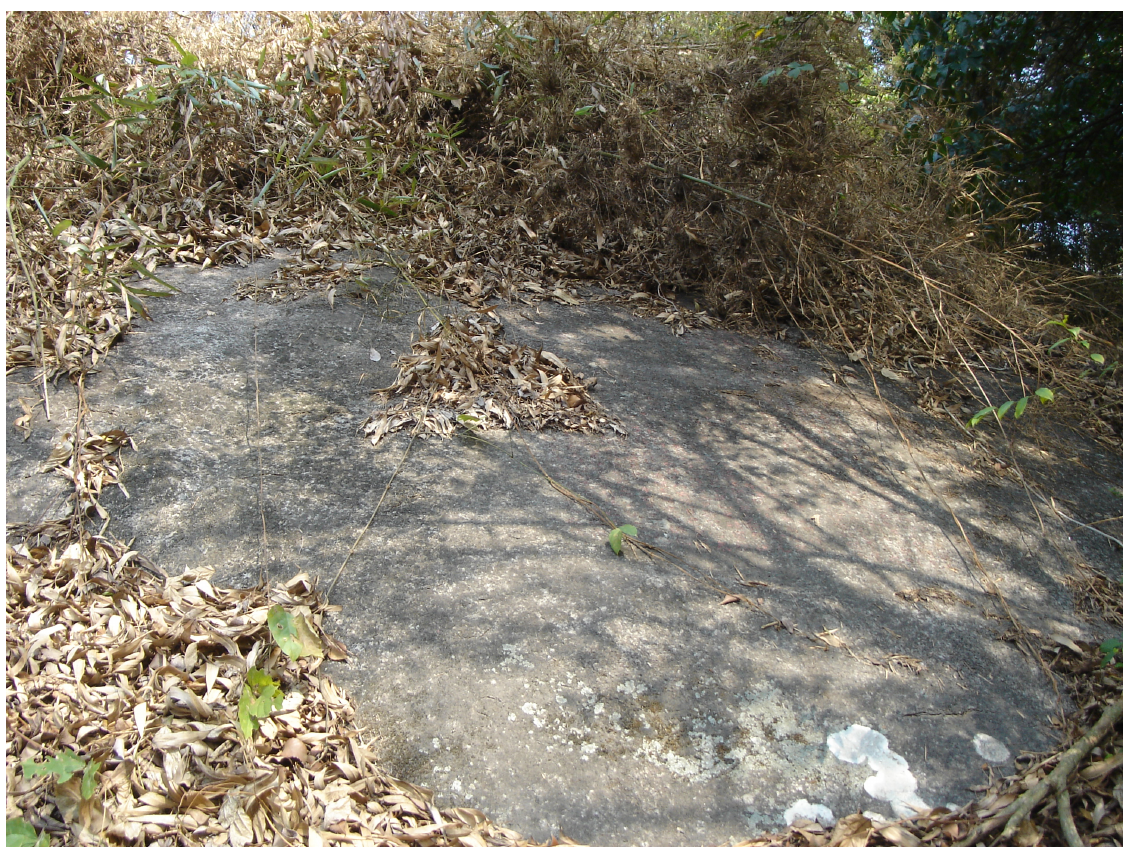
Figure 4 The condition of the record of the reconstruction of the Chunyang cave in Qingyuan moun- tain. Taken by the author on January 6,